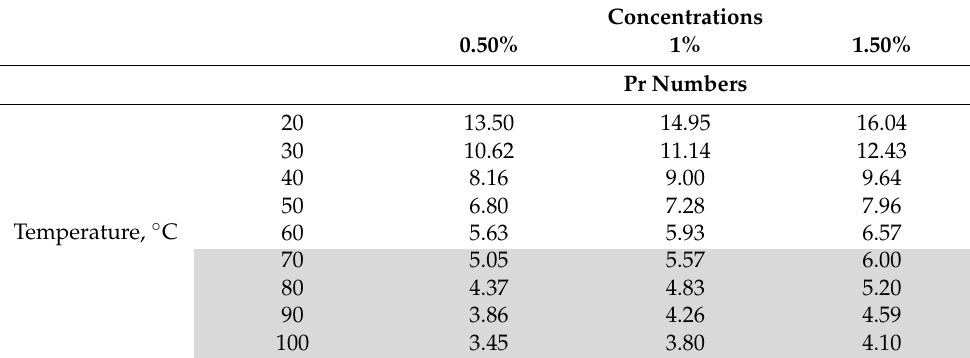
Table 5. The Pr numbers of SiO 2 -P25 hybrid nanofluids for different concentrations.